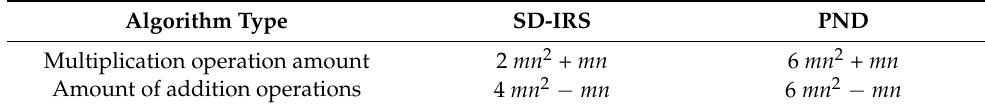
Table 10. Algorithm computation volume comparison.